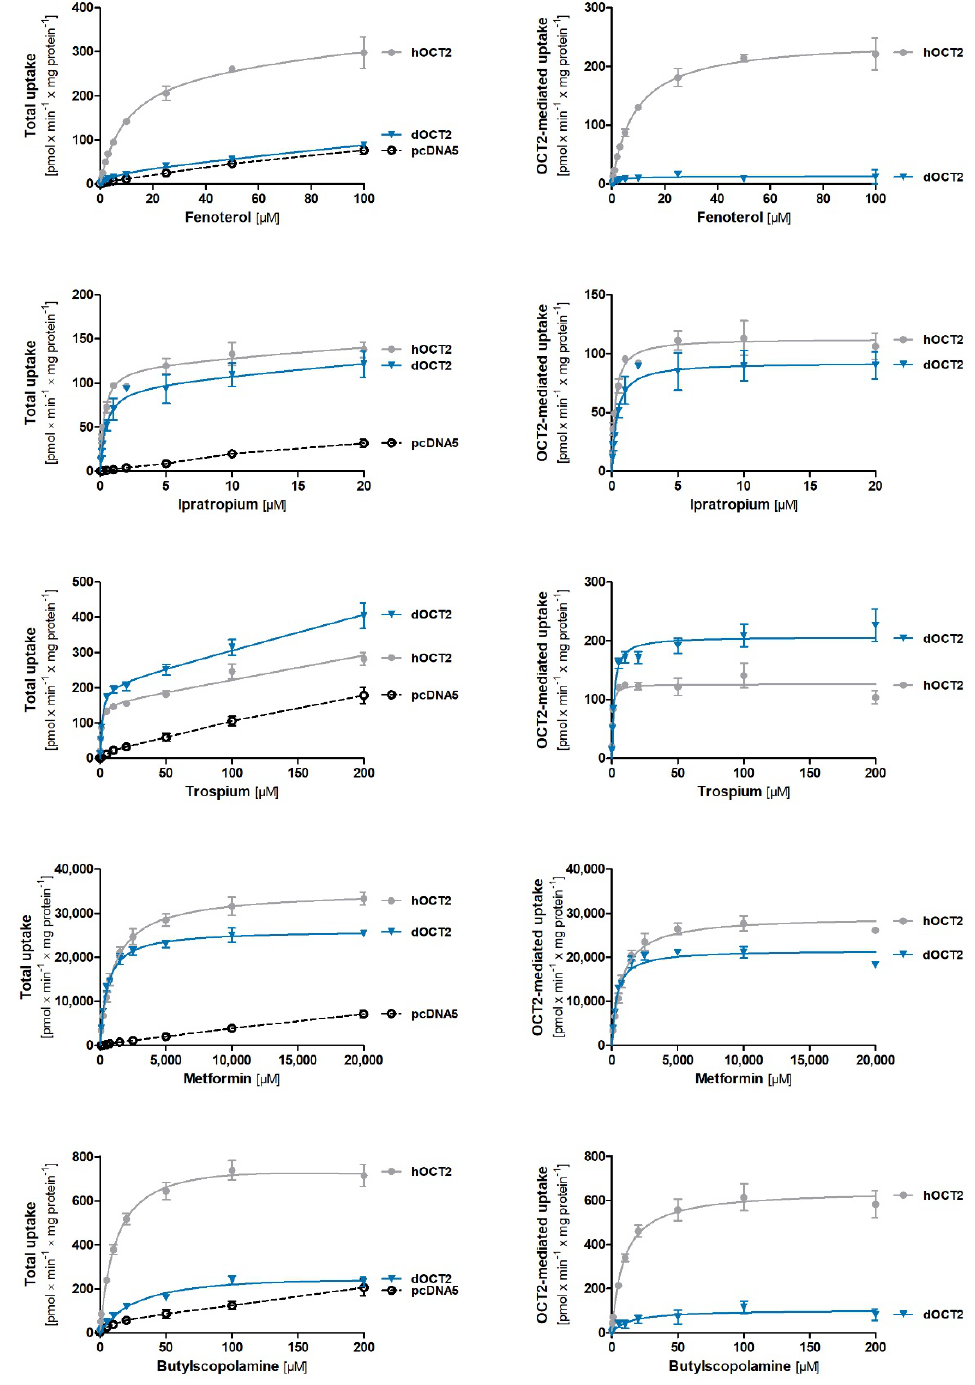
Figure 6. Comparative characterization of substrate uptake between dog and human OCT2 orthologs. HEK293 cells stably transfected to overexpress dog (blue) and human (grey) OCT2 were incubated for 2 min with increasing concentrations of fenoterol, ipratropium, trospium, metformin, and butylscopolamine. The total uptake is shown for the overexpressing and control cells (left hand side). OCT2-mediated uptake (right hand side) was calculated by subtracting the uptake of control cells (pcDNA5) from the uptake of OCT2-overexpressing cells. The means and standard errors of the means are shown for at least three independent experiments. An Eadie–Hofstee transformation of the data is shown in Figure S6.